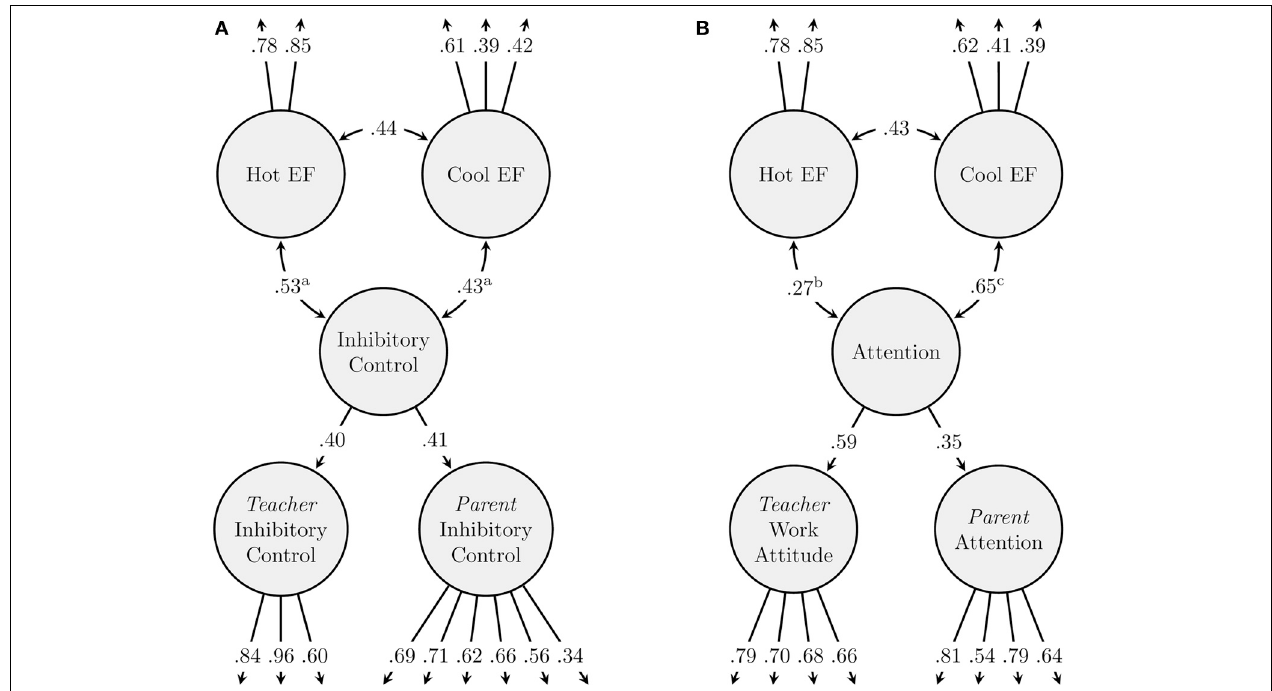
FIGURE 1 | (A) Convergent validity model: Association between cool and hot EF and report-based inhibitory control. Age, gender, SES, home language, and cohort were included as covariates in the model. (B) Convergent validity